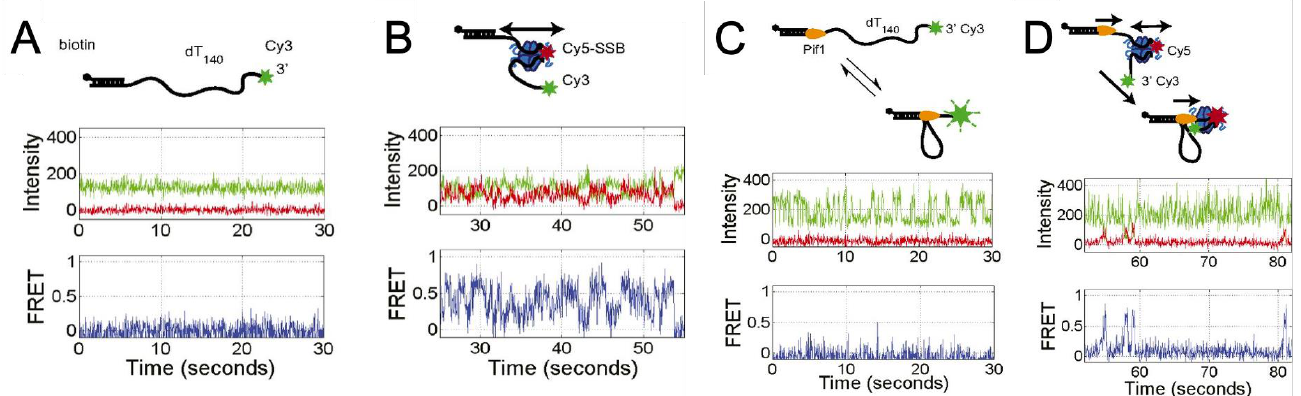
Figure 8. Example of single-molecule FRET assay to chemo-mechanical pushing of E. coli SSB by translocating protein partner Pif1 [220]. ( A ) A representative fluorescence trace of a Cy3–ssDNA (green) construct displays only Cy3 fluorescence without SSB or Pif1. ( B ) Following the binding of Cy5–SSB (red) to ssDNA constructs, fluctuating FRET signals are observed as a result of SSB diffusion along ssDNA. ( C ) Adding Pif1 (and ATP as an energy source) to the Cy3–ssDNA construct generates repetitive Cy3 enhancement spikes (PIFE) in the absence of SSB. ( D ) After Cy5–SSB is prebound on Cy3–ssDNA, Pif1 is then added with ATP into the experimental solution, replacing the FRET signal of SSB diffusion with the PIFE signal of Pif1 translocation. Periodically occurring asymmetric FRET spikes indicate SSB is pushed by Pif1 in a 5 (cid:48) to 3 (cid:48) direction. Images reused from [220]. Copyright 2016 National Academy of